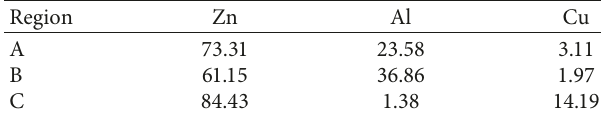
Table 2: EDS analysis results of regions A, B, and C in Figure 4. Region Zn